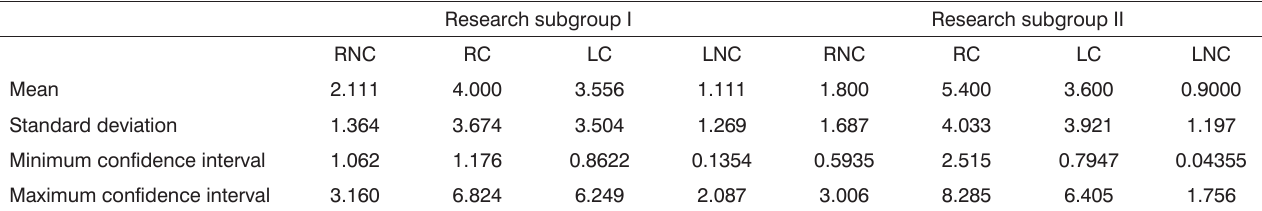
Table 2. Statistical analysis for research subgroups I and